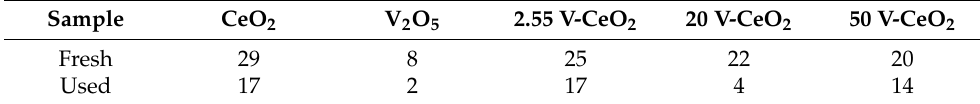
Table 4. Specific surface area (SSA, m 2 /g) of the fresh and used catalysts.